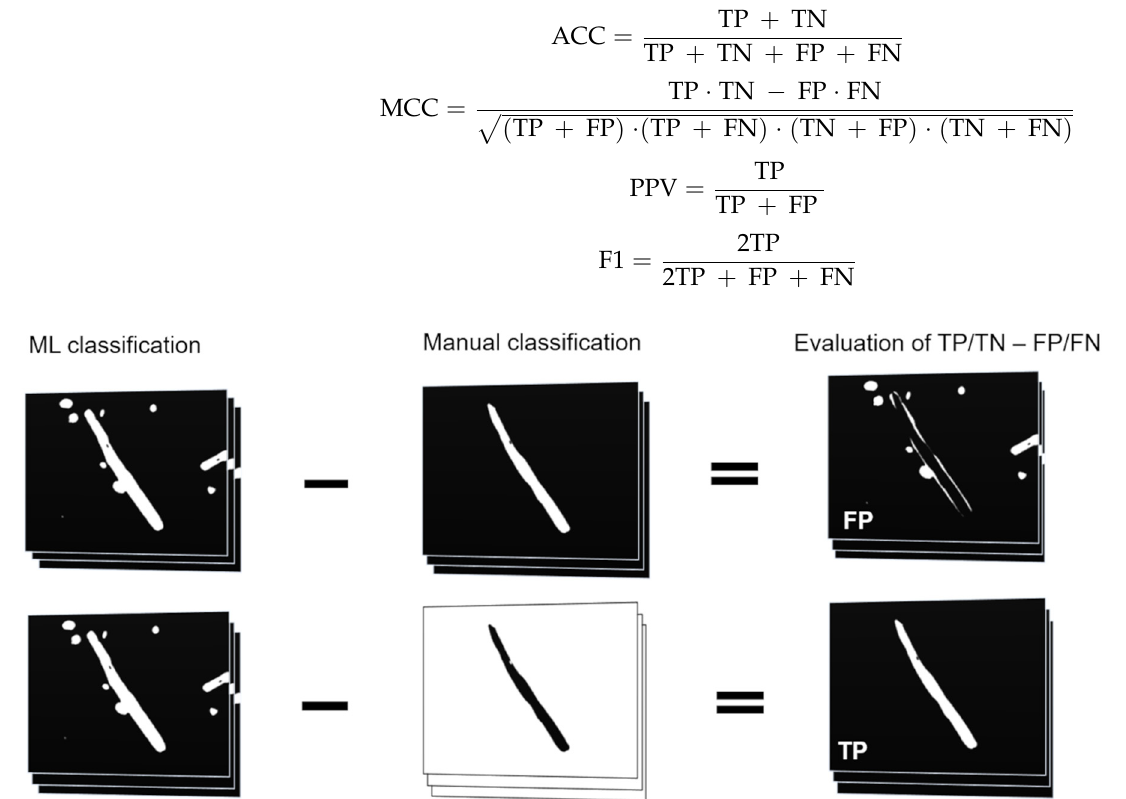
Figure 2. Calculation of FP and TP areas. Manual classification results were subtracted from machine-learning classification results and the areas were measured to obtain FP and TP values. In case of TP the manual classification results had to be inverted prior to subtraction.